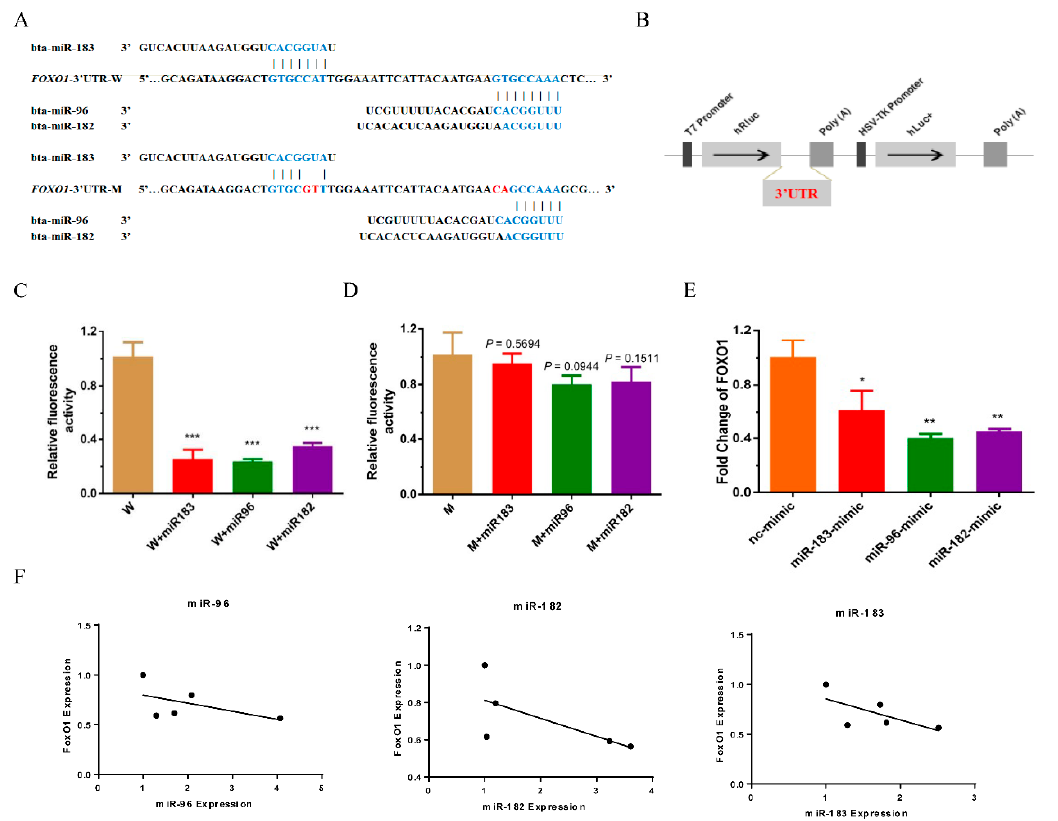
Figure 4. FoxO1 was the target of the miR-183/96/182 cluster. ( A ) The distribution of potential binding sites of the miR-183/96/182 cluster in the 3 ′ UTR of FoxO1 . The red letters indicate the certain mutated bases. ( B ) The illustration shows the construct of a dual-luciferase reporter system. ( C , D ) The luciferase activity of the FoxO1 (wild or mutant) psi-check2 reporter vector was detected after co-transfection of the miR-183/96/182 cluster mimics in HEK293T cells. ( E ) The mRNA of FoxO1 were detected by RT-qPCR after transfection of the miR-183/96/182 cluster mimics and inhibitors. ( F ) The correlation analysis on the expression of FoxO1 and the miR-183/96/182 cluster during myoblast differentiation. Data are presented as the means ± SEM. * p < 0.05, ** p < 0.01 and *** p < 0.001.